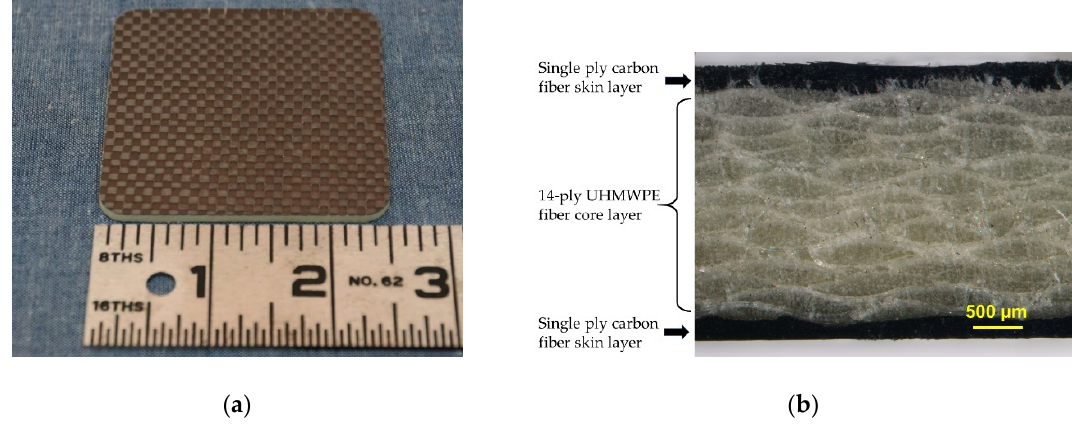
Figure 5. ( a ) Perspective view of a composite sample with carbon fiber skin layers; ( b ) cross-sectional micrograph of a composite with carbon fiber skin layers.